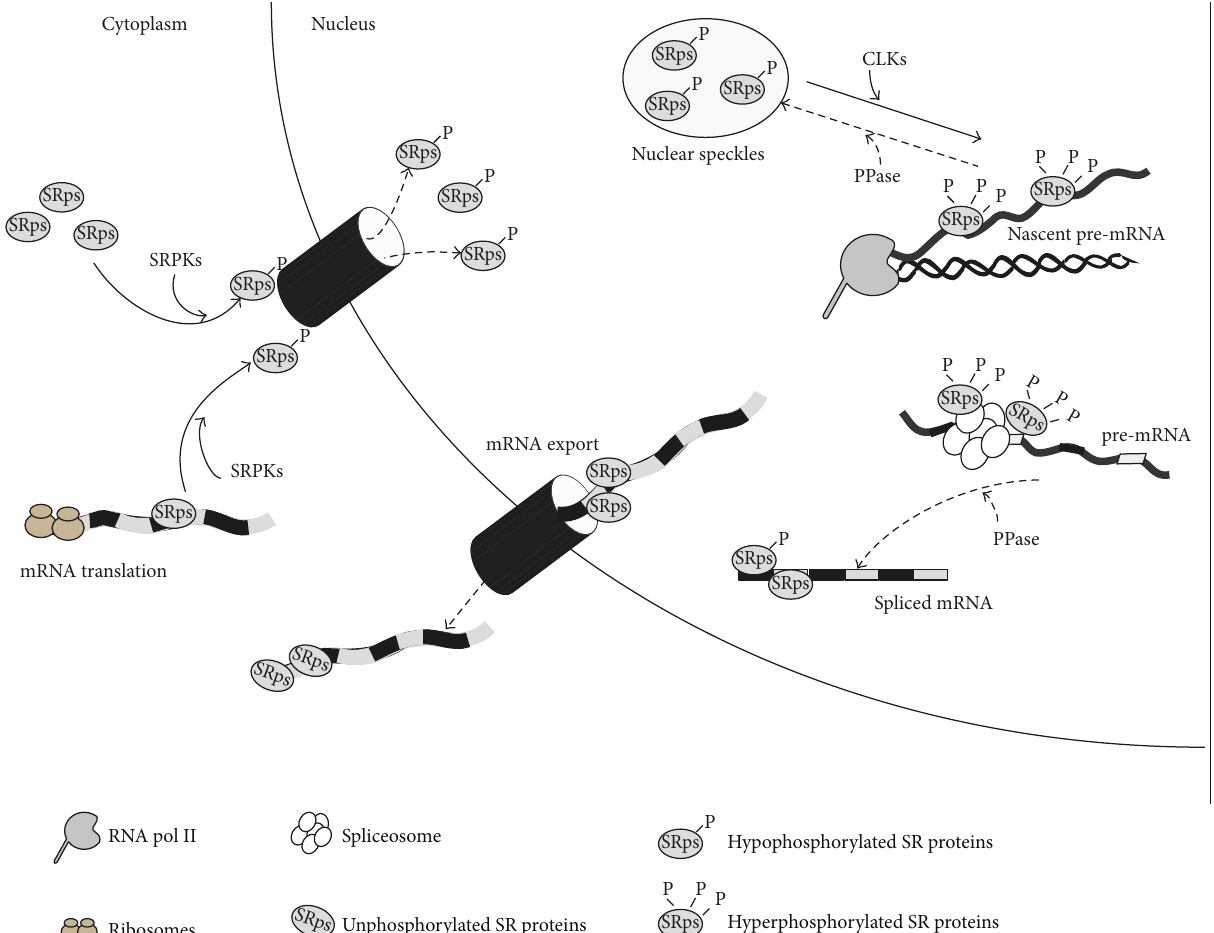
Figure 1: Phosphorylation-mediated regulation of SR proteins activity. Reversible phosphorylation of their RS domain profoundly affect SR protein (SRps) activity and subcellular localization. Newly synthesized SRps need SRPK-mediated phosphorylation in order to enter the nucleus and assemble in nuclear speckles. CLKs mediate SRps hyperphosphorylation and induce their release from nuclear speckles and their recruitment to transcription sites. Dephosphorylation of SRps is successively required for proper splicing catalysis. Moreover, dephosphorylated SRps facilitate export of spliced mRNA in the cytosol, where they enhance protein